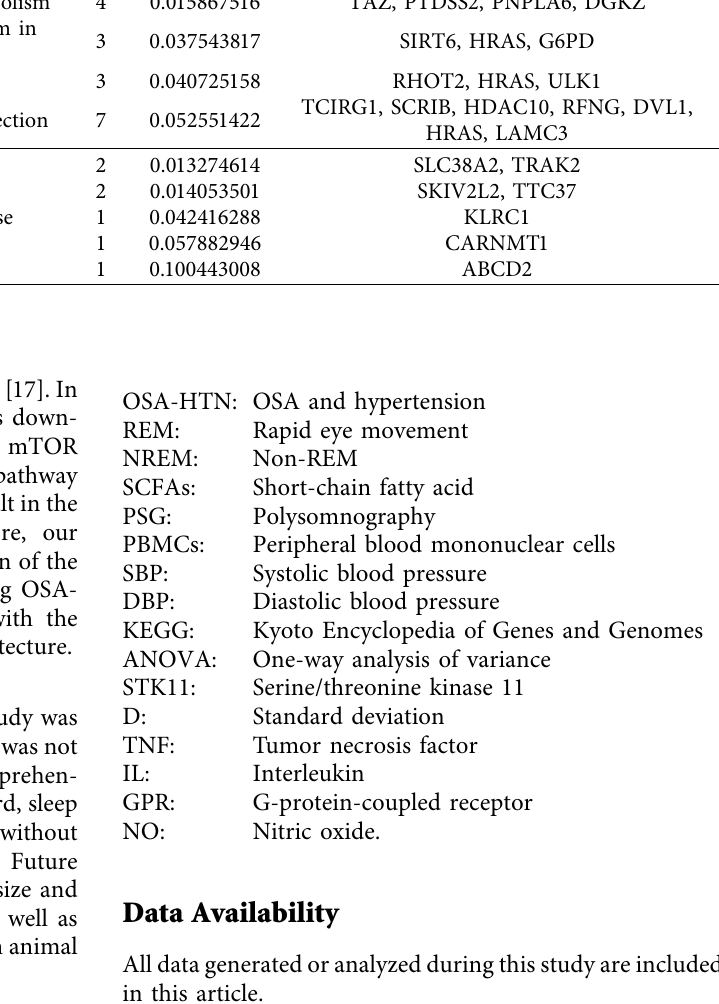
Table 4: KEGG differential genes analysis in severe-OSA with HTN patients compared with non-OSA without hypertension subjects. Expression ID Pathways Counts